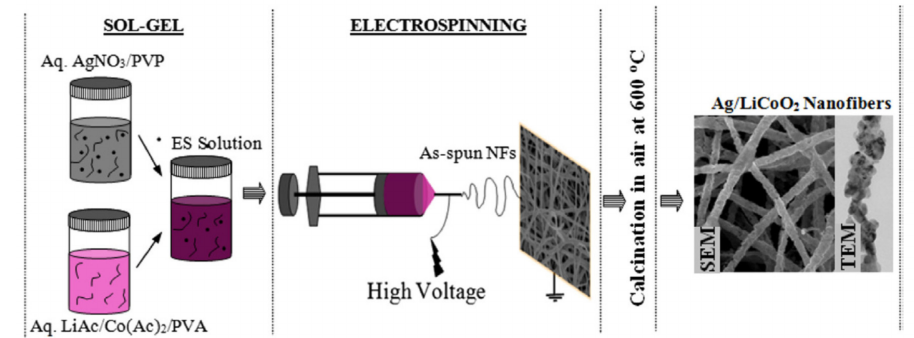
Figure 3. Schematic of sol-gel electrospinning Ag / LiCoO 2 nanofibers and the images. Reprinted with permission from [51]. Copyright © 2020 Elsevier